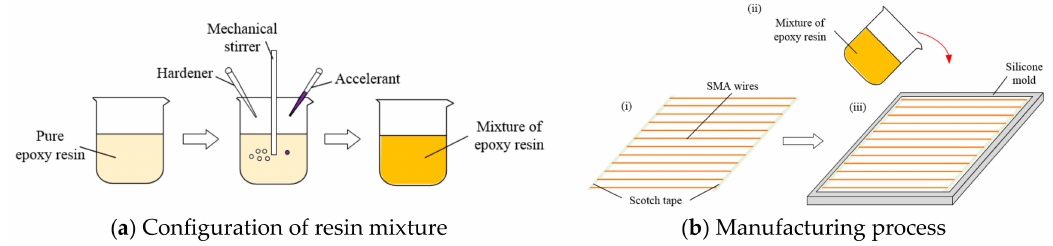
Figure 3. The overall preparation process of the SMA reinforced polymer